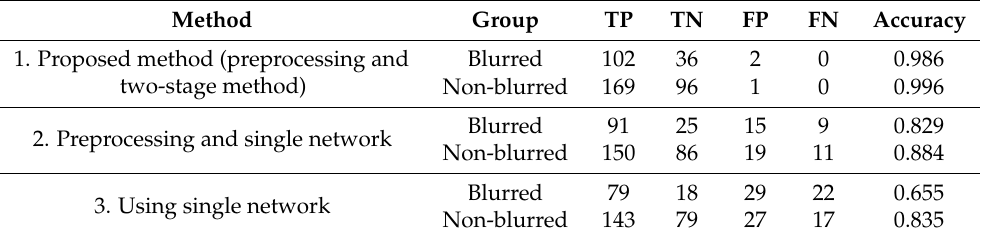
Table 3. Inspection accuracy using the three